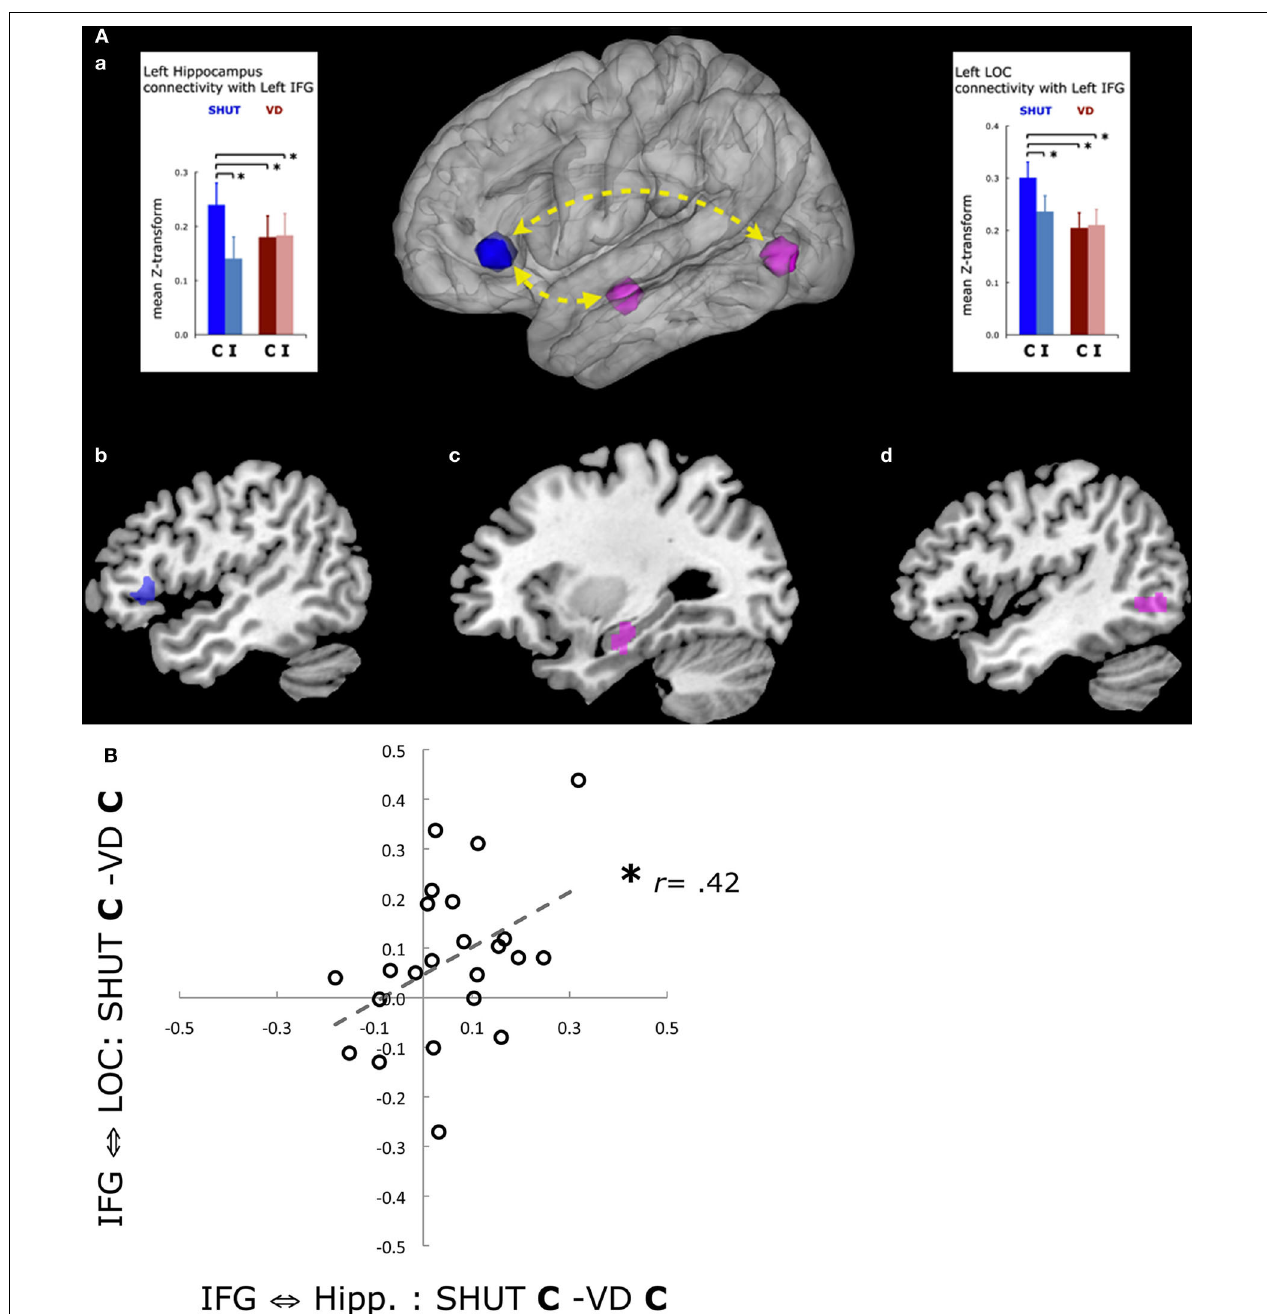
FIGURE 3 | (A) fMRIresultsassociatedwithvisualdistraction.Theconjunction of functional connectivity with the left IFG was mapped by the whole-brain comparison of beta-series correlations seeded by the left hippocampal ROI identified in the univariate analysis and by the left LOC cluster identified in the independent functional localizer task(Waiset al.,2010). Further comparisons in this memory retrieval network revealed that functional connectivity was disrupted during VD correct, relative to SHUT correct. (a) A schematic of the network is shown with functional connectivity between the regions plotted as the mean z-score transformation of the beta-series correlations for each of four categories for responses to the targets. The network regions include: (b) the